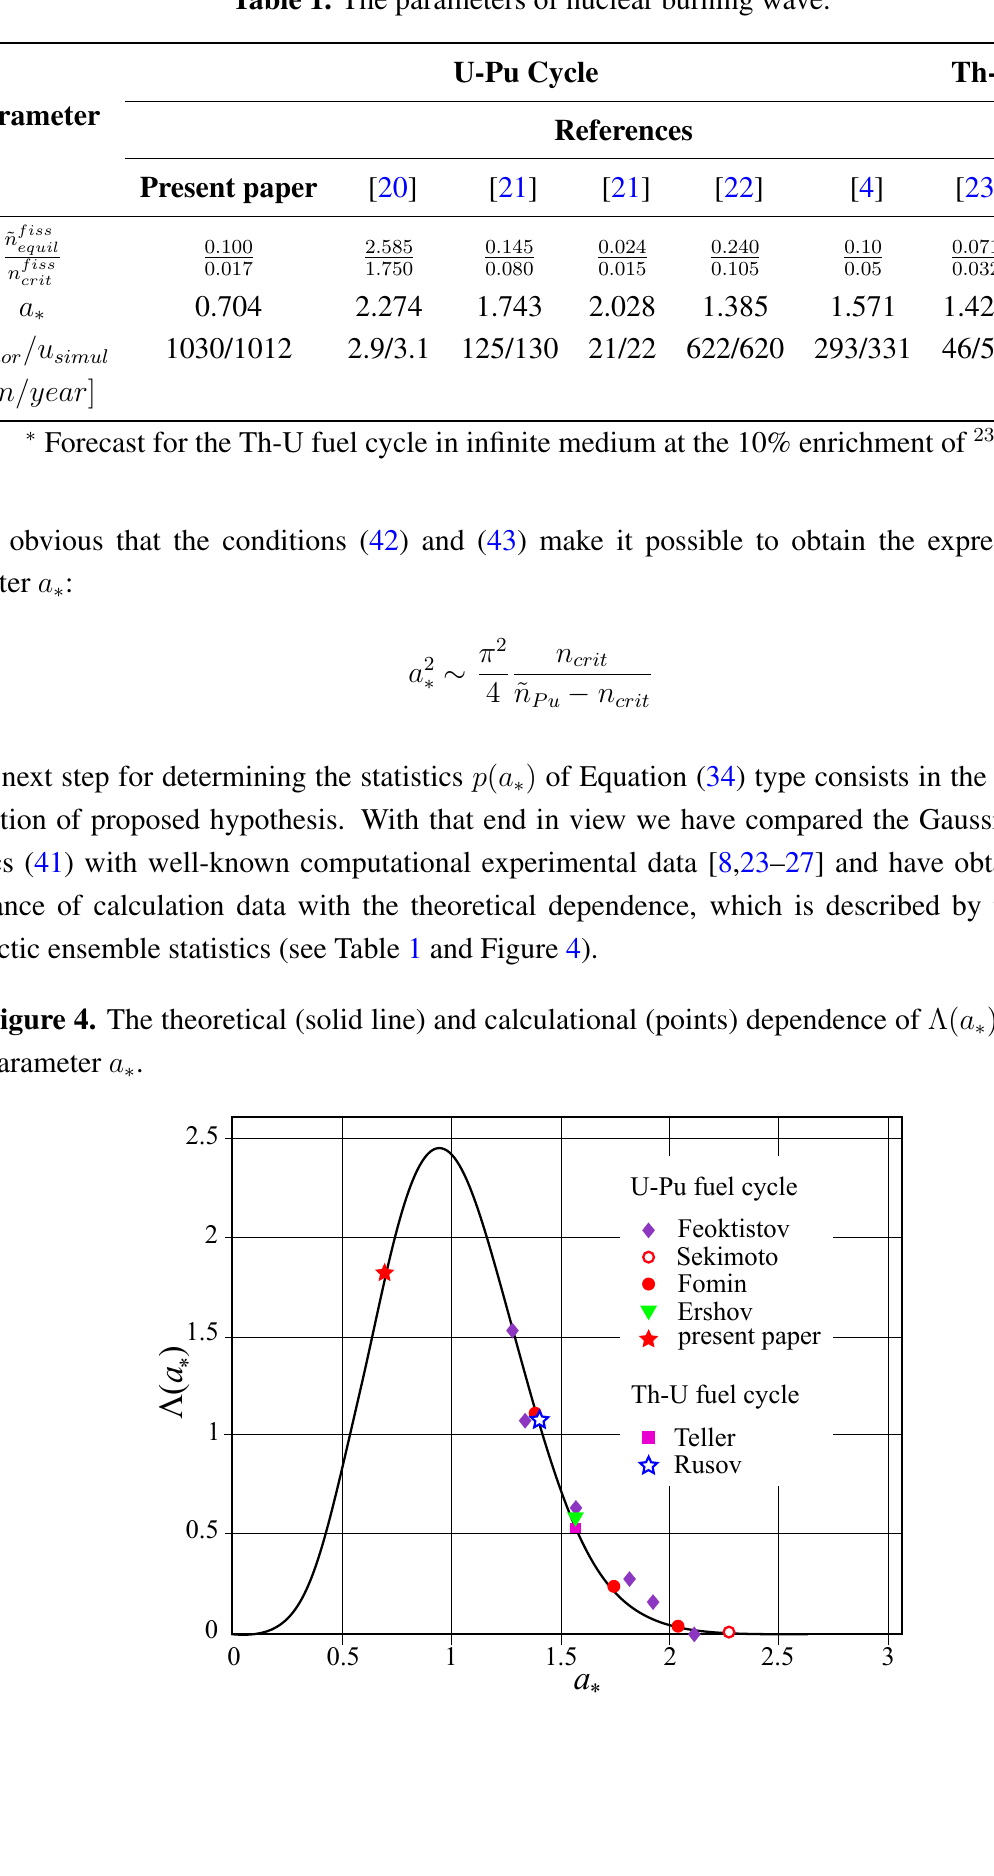
Table 1. The parameters of nuclear burning wave.